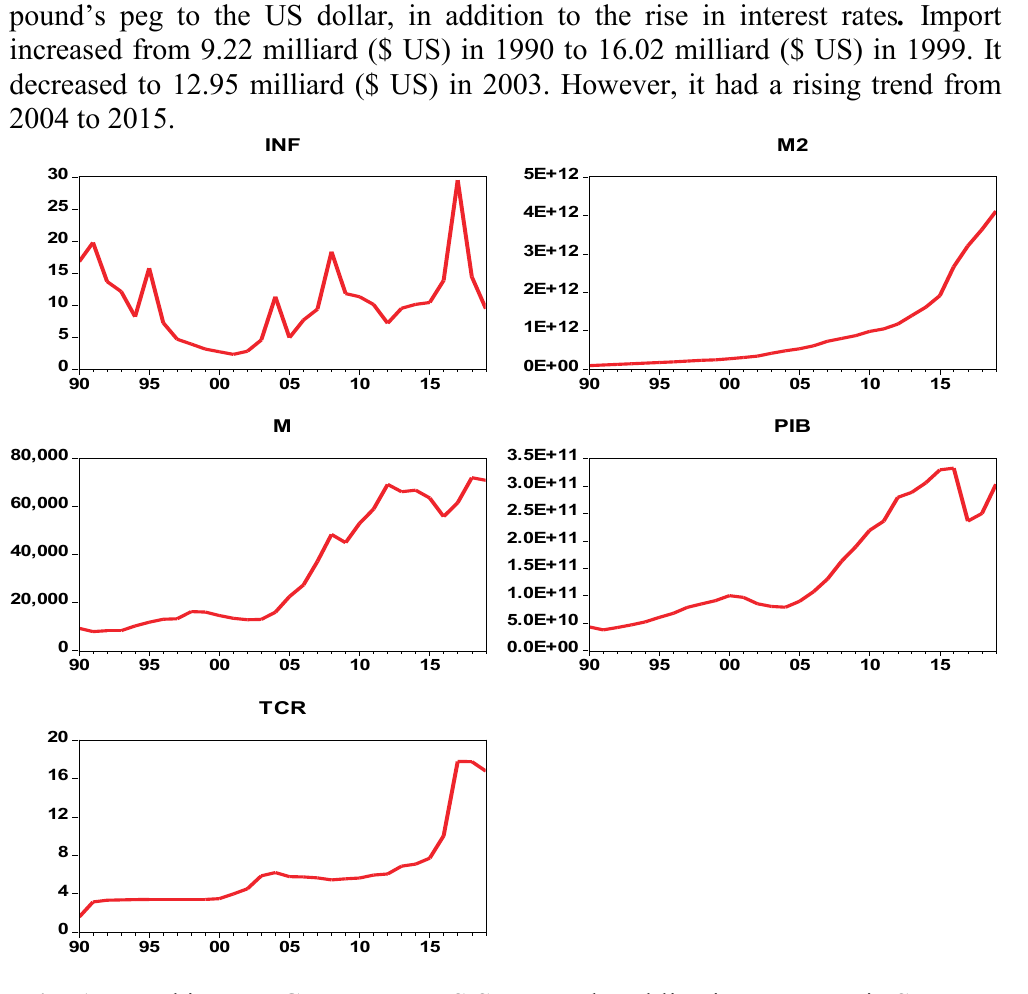
Fig. 1. Trend in INF, GDP, IMP, MS State Bank Publication, Economic Surveys of different years (Bozkurt, 2014; World Bank Open Data,